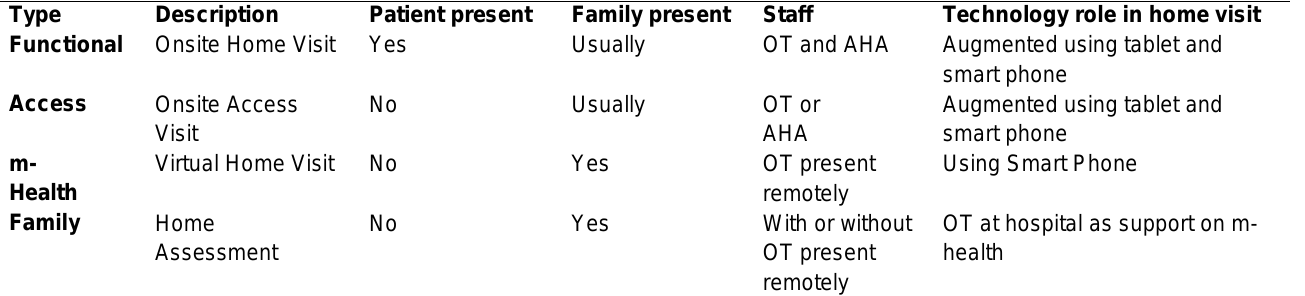
Table 2. Home Quick